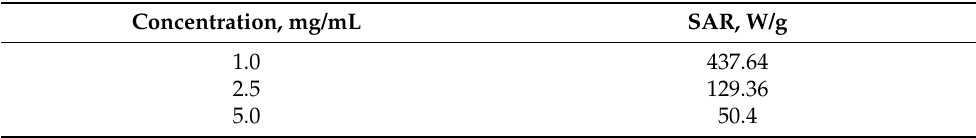
Table 2. Specific absorption rate (SAR) at different concentrations of Fe@C nanoparticles.